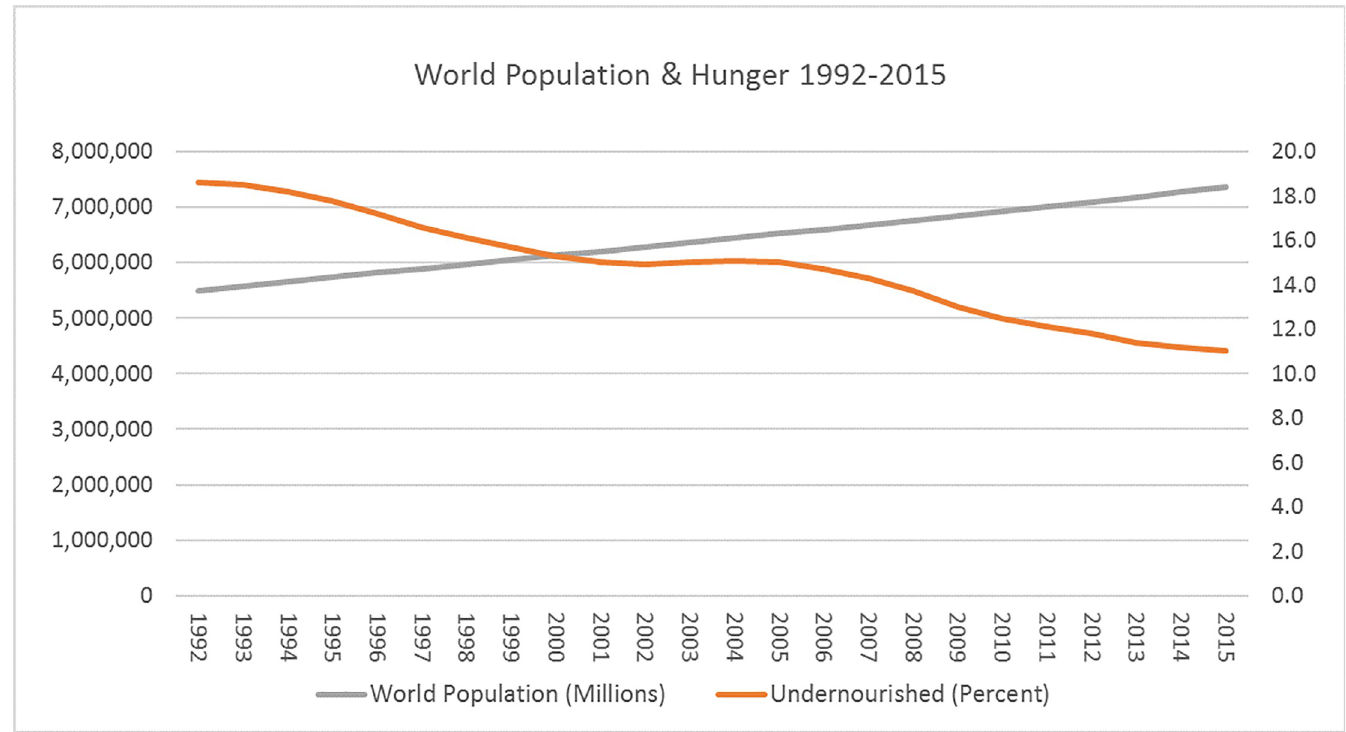
Fig 2. The relationship between world population and world hunger (under-nourishment) 1992 to 2015. Source: Compiled by authors based on data from the FAOStat database maintained by the Food and Agriculture Organization of the United Nations. Data retrieved from http://www.fao.org/faostat/en/#home on January 20,